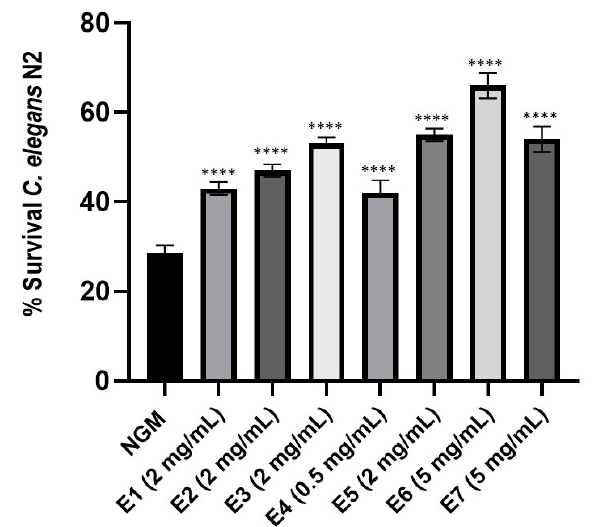
Figure 5. Percentage of Caenorhabditis elegans N2 fed with control condition (OP50) or with each peppermint extract E1–E7 at the respective optimal dose. Data correspond to the average of two independent assays. A one-way ANOVA test with a Tukey’s multiple comparison pots-test was applied. **** Significant at p -value < 0.0001 in comparison to NGM